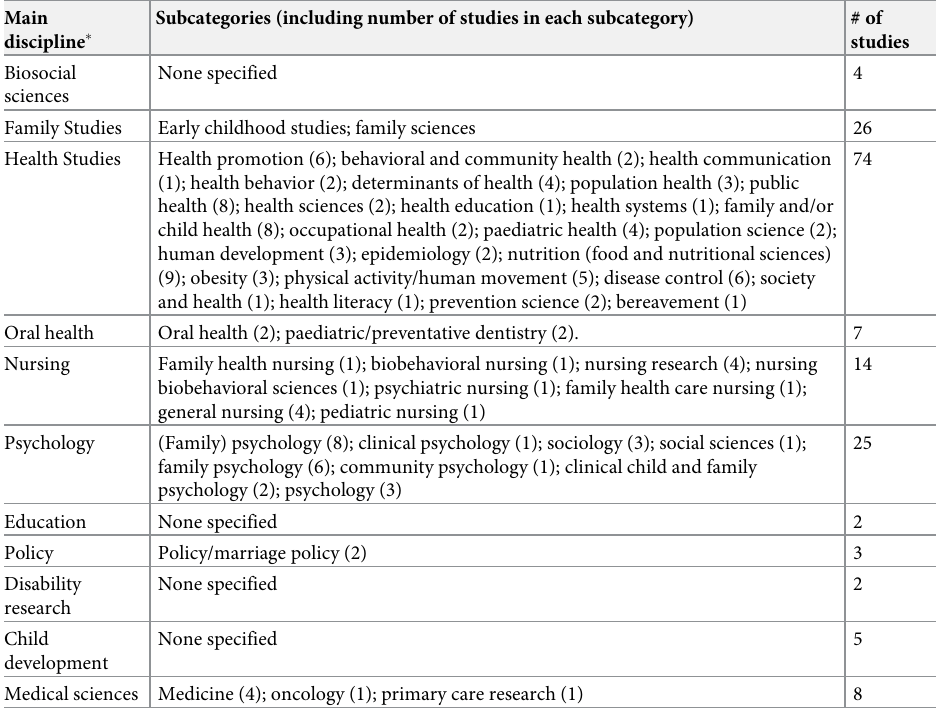
Table 2. Description of studies by